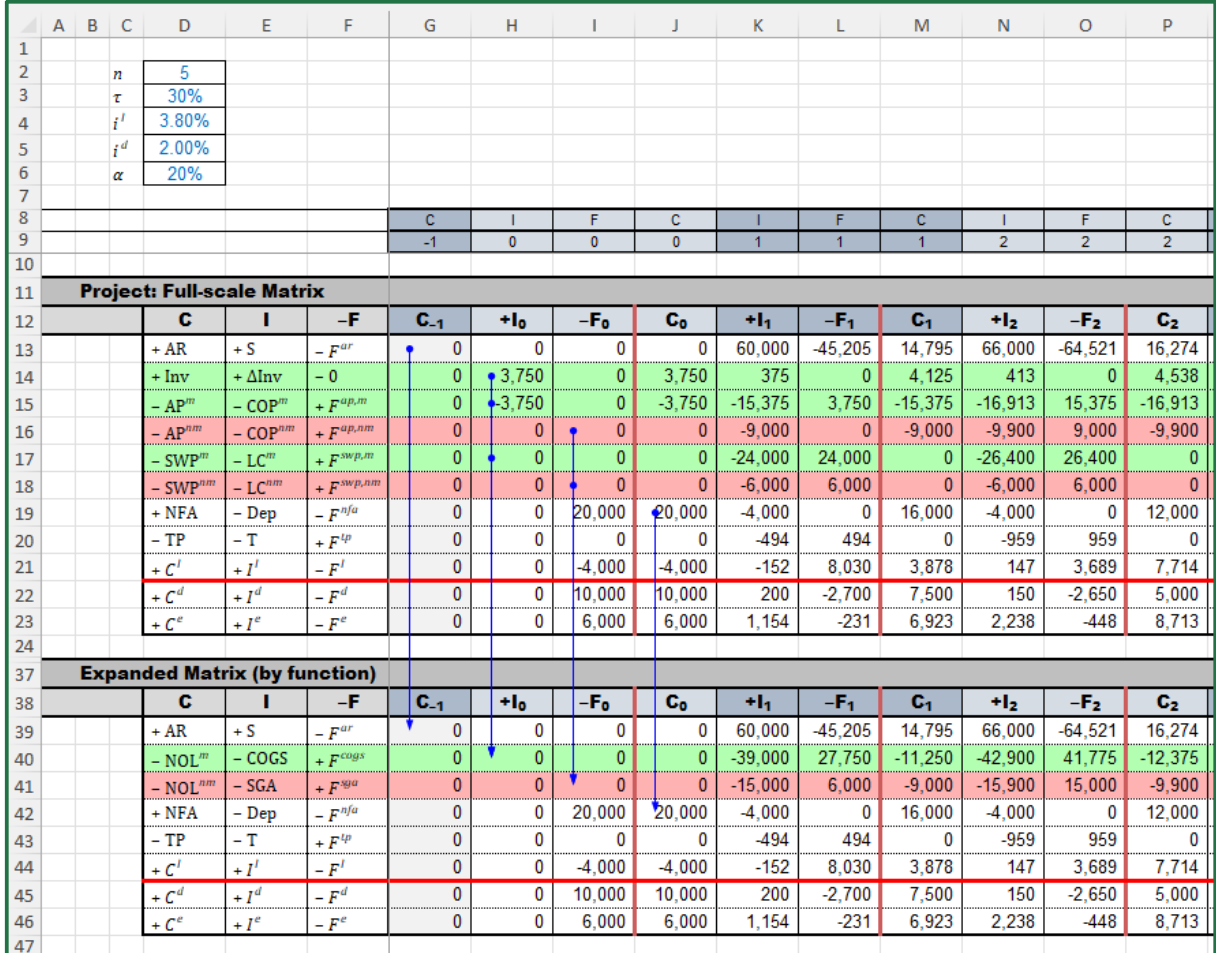
Figure 27. The strip of expanded matrices (by function) (“SplitScreenStrip” sheet). The rows with the same color in the Full-scale Matrix are consolidated into one row of the same color in the Expanded Matrix.